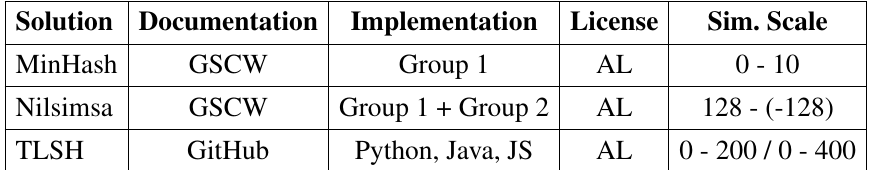
Table 3. Documentation, Implementation, License, and Similarity Scale